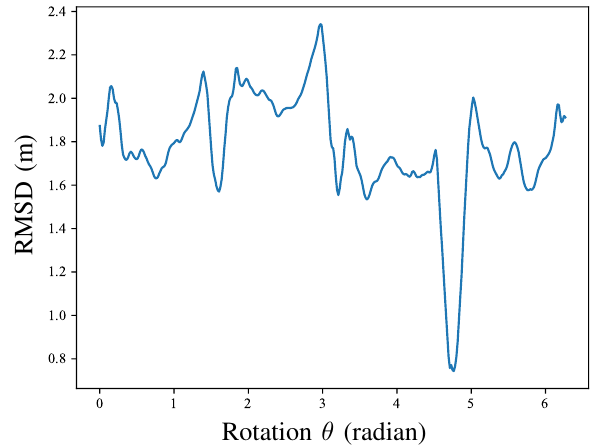
Figure 5. Example registration RMSD curve against the Fig. 6. Example registration RMSD curve against the rotation.